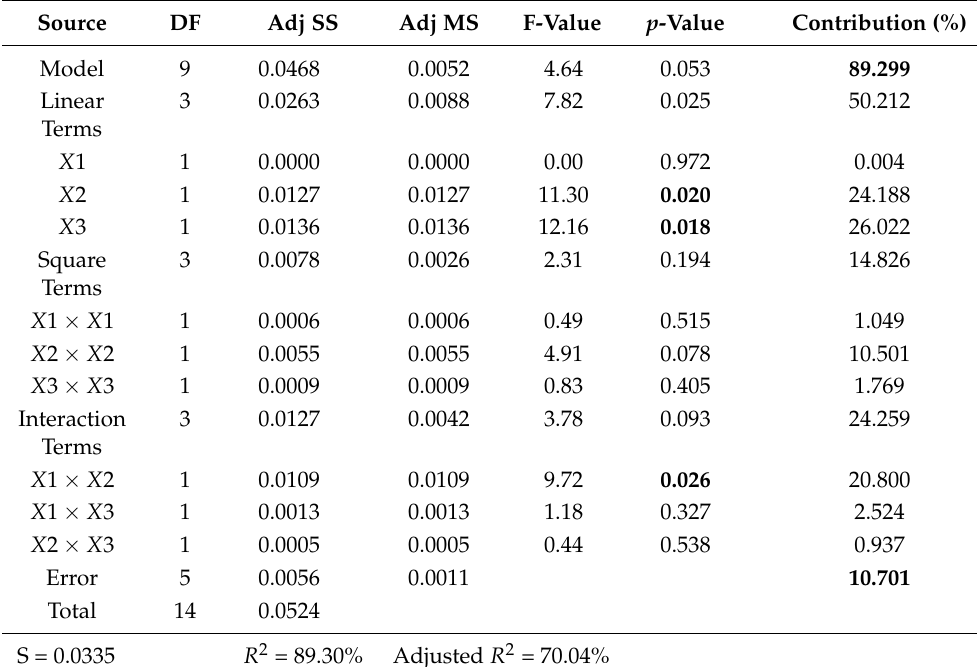
Table 9. Analysis of variance (ANOVA) for GRG